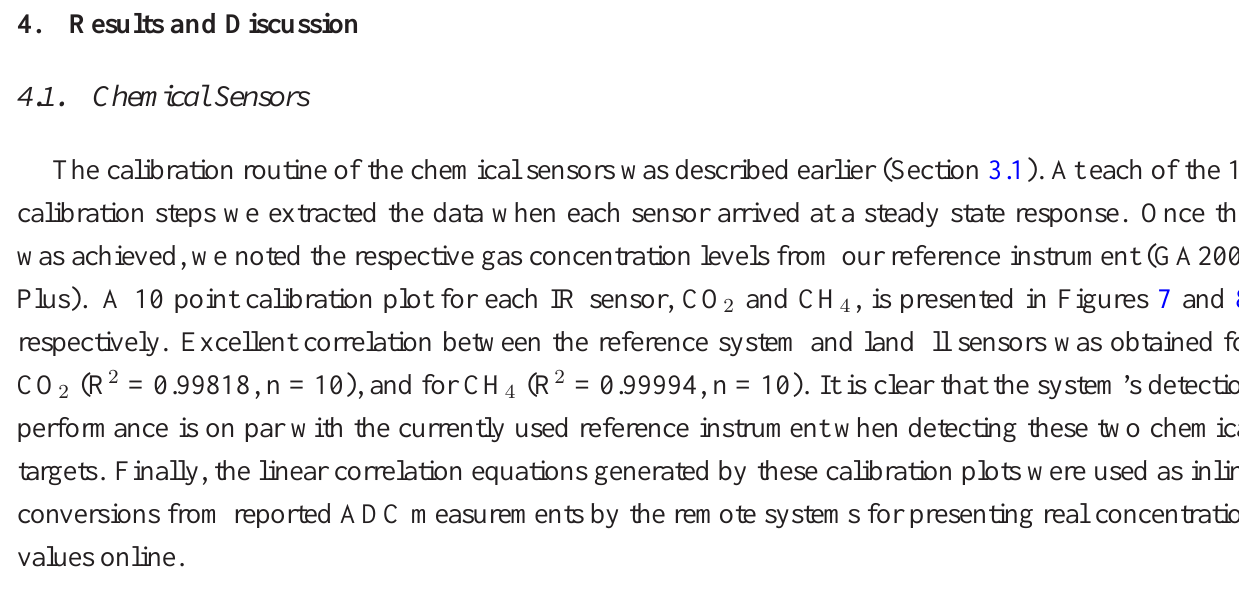
Figure 7. Calibration of the system’s CO 2 infrared gas sensor. Points represent the average of the steady state response over circa 2 minutes. Error bars (present but difficult to see due to the high sensor accuracy) represent the standard